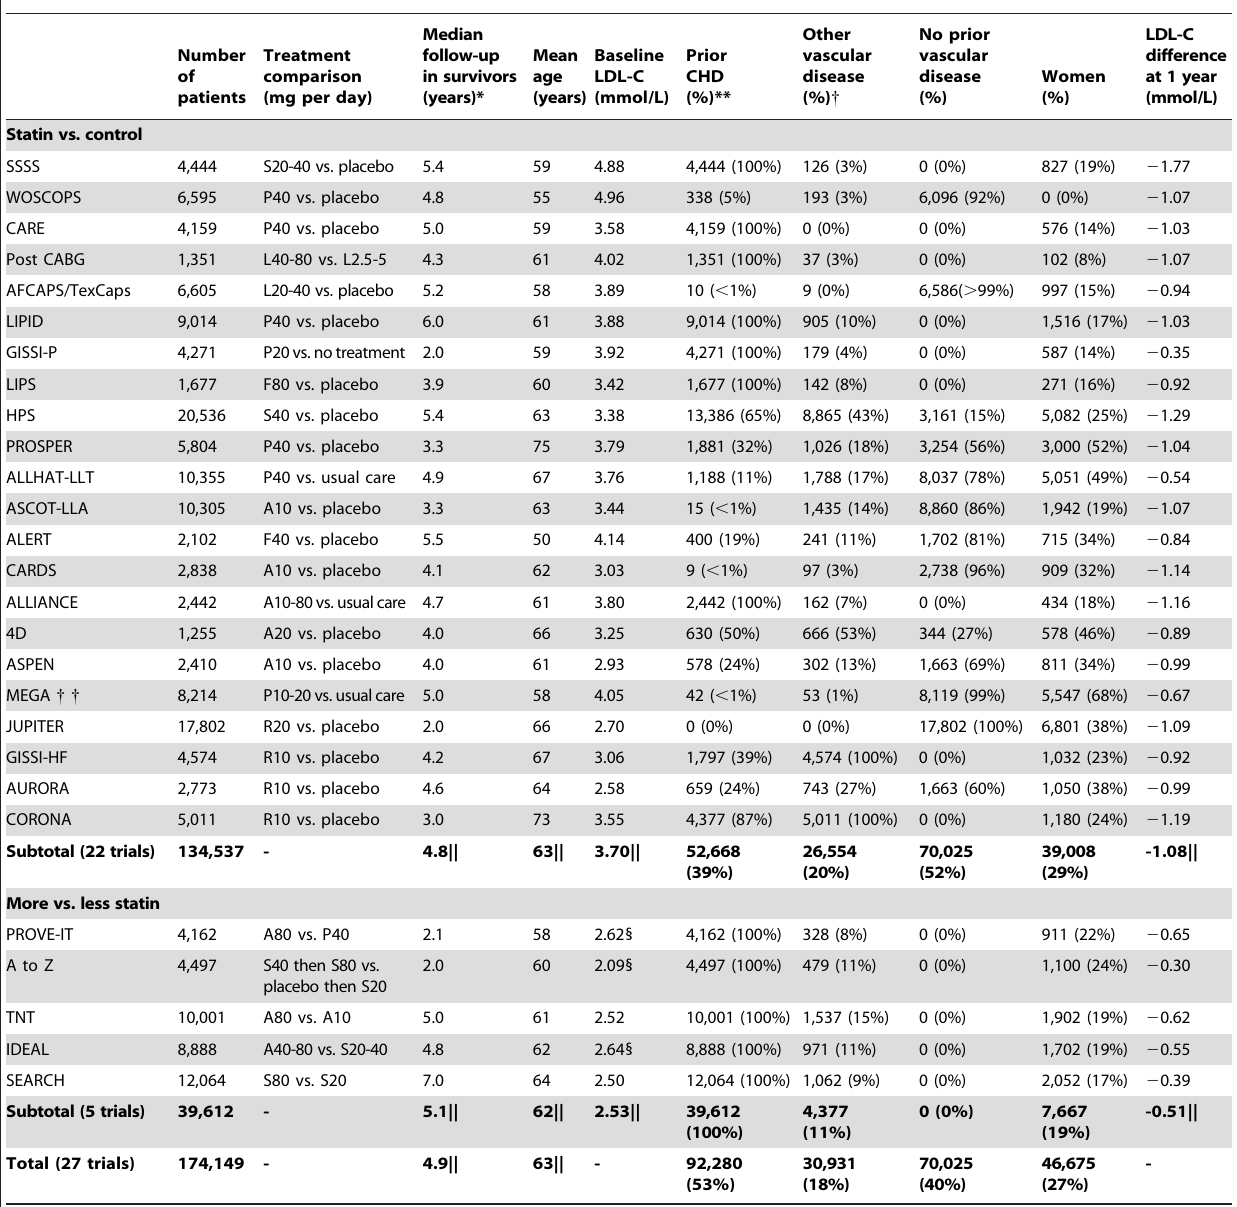
Table 1. Baseline characteristics and eligibility criteria of participating